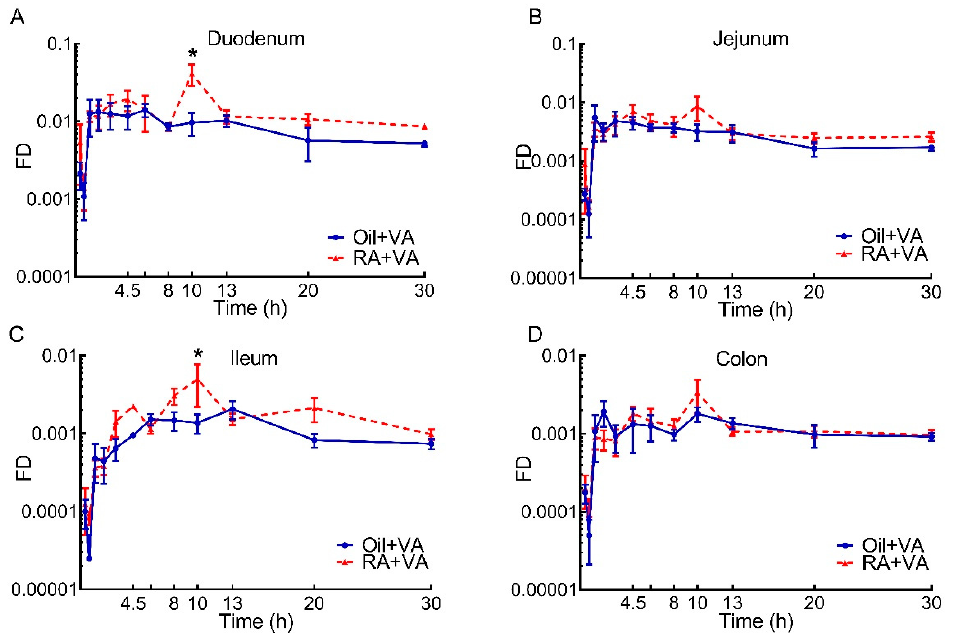
. Figure 4. Regional distribution of fraction of ingested dose (FD) vs. time after administration of 3 H-labeled VA supplement in neonatal rats: ( A ) Duodenum; ( B ) Jejunum; ( C ) Ileum; ( D ) Colon. Data are presented as means ± SEM, n = 4–6 pups/time/group. * indicates statistically significant difference between groups, p <